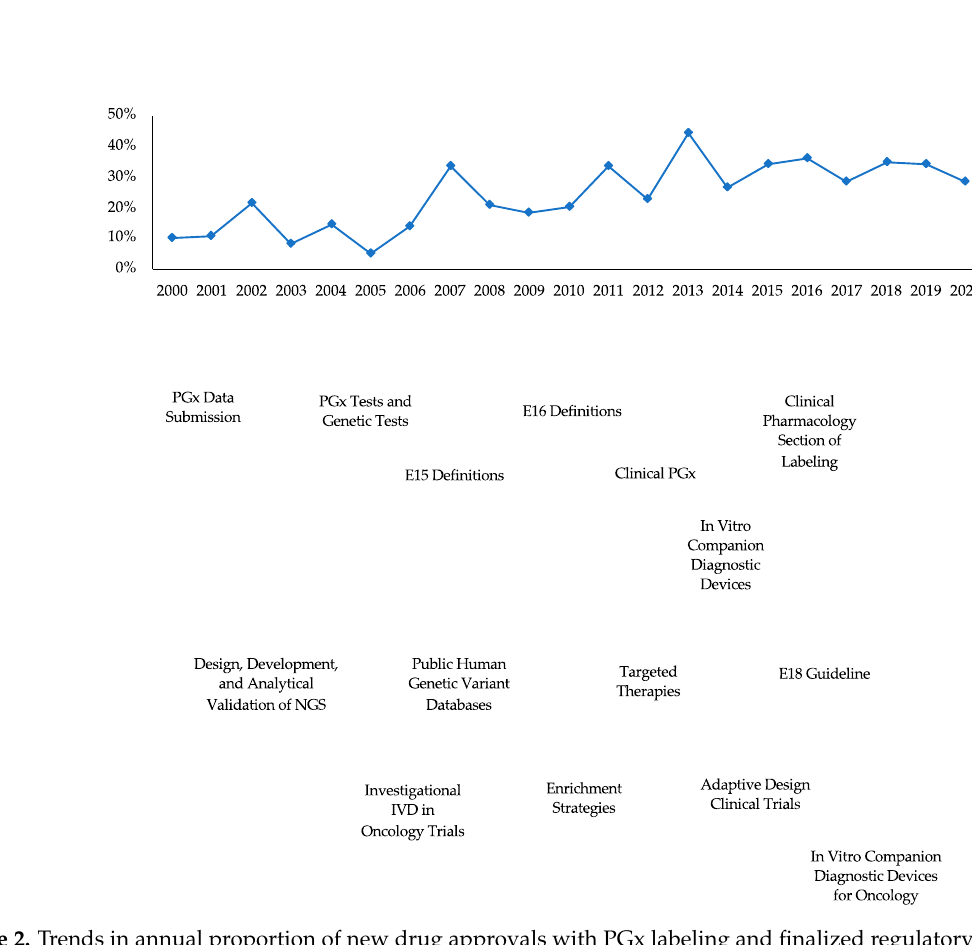
Table 1. Annual proportion of drug approvals with PGx labeling for cancer vs. non-cancer indications. All Cancer Non-Cancer